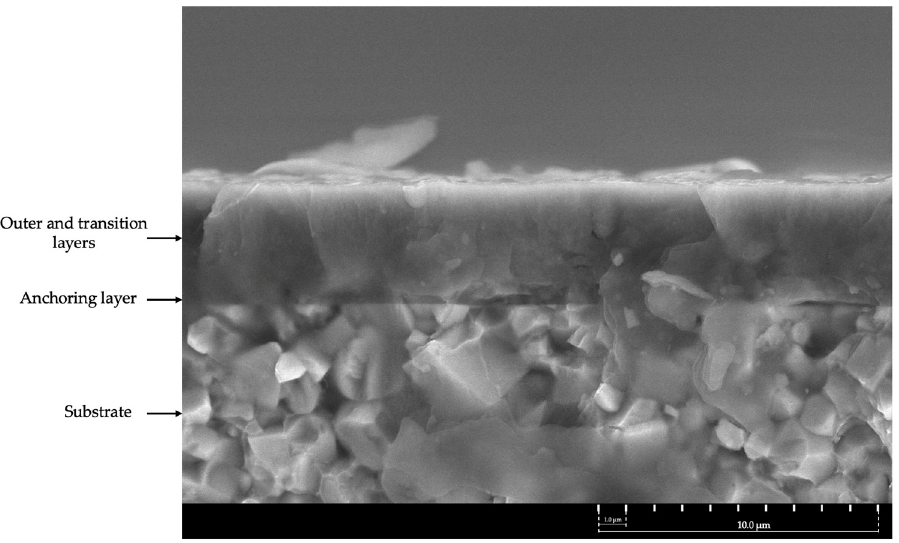
Figure 5. Cross-section SEM image with the AlCrSiN coating’s structure in the WC-TiC-Co sub- strate.